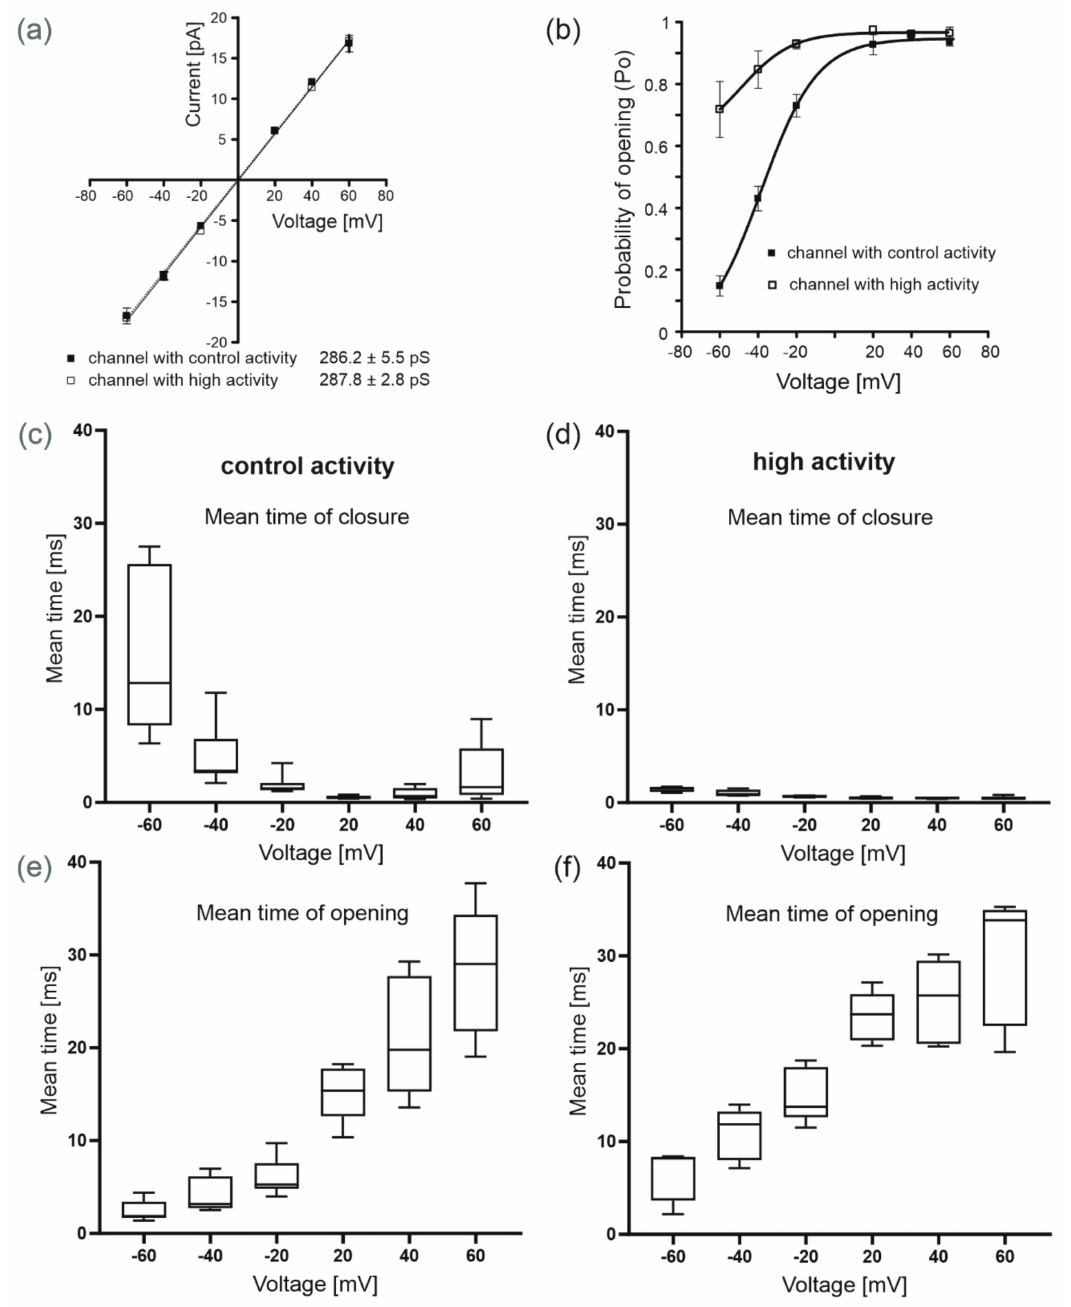
Figure 2. Biophysical properties of both mitoBK Ca channels (channels with control and high activity) present in the inner mitochondrial membranes of human bronchial epithelial cells. ( a ) The current-voltage relationship based on single-channel recordings in a symmetric 150/150 mM KCl isotonic solution (100 µ M Ca 2+ ) of the channel with control and high activity ( n = 4). ( b ) Analysis of the open probability of the mitoBK Ca channels with control and high activities in the presence of 100 µ M Ca 2+ at different voltages ( n = 4). ( c , e ) Distribution of the mean times of closure and opening of the mitoBK Ca channel with control activity ( n = 4). ( d , f ) Distribution of the mean times of closure and opening of the mitoBK Ca channel with high activity ( n = 3). Notes: ( a , b ) data are presented as the means ± SD under control conditions (100 µ M Ca 2+ ); ( c – f ) the boxes include values for the mean time, the line across the box indicates the median, and whiskers show the minimum and maximum values for mean time of